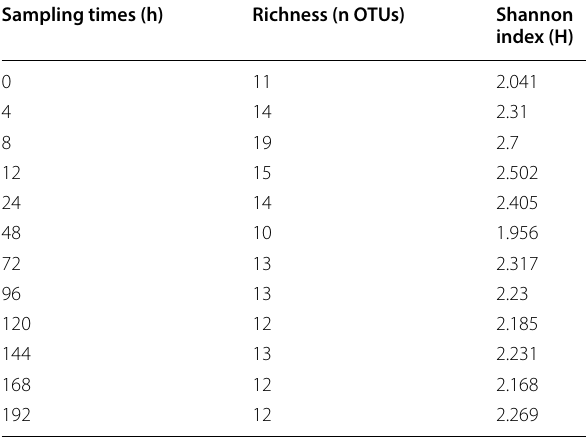
Table 1 Diversity analysis obtained from DGGE pattern related to richness and Shannon index Sampling times